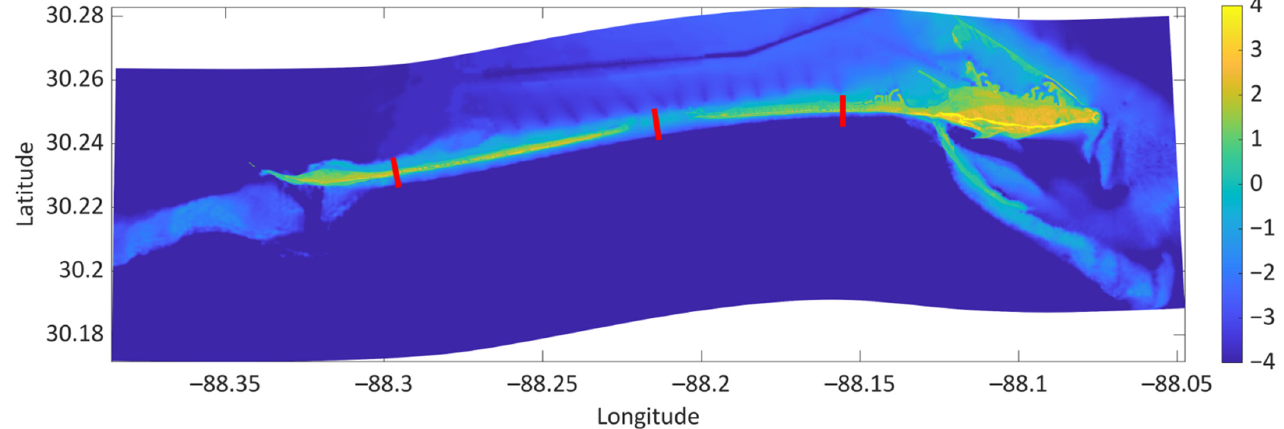
Figure 4. XBeach model domain, presimulation elevations (m, NAVD88), and cross-shore transects (red lines) for Dauphin Island, AL analyzed in this study.